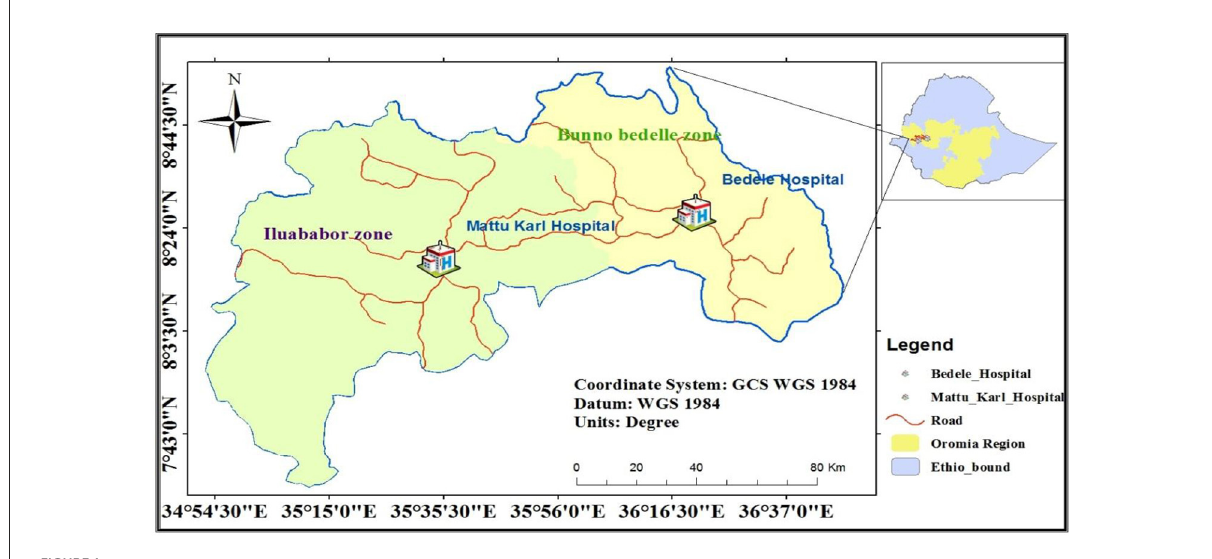
FIGURE1 Study area